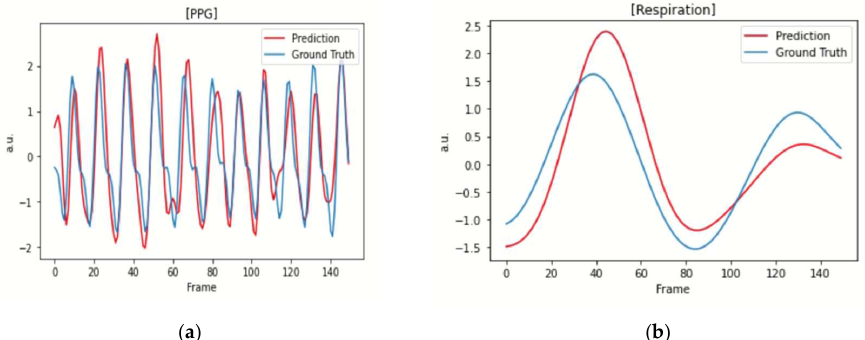
Figure 6. Examples of the predicted PPG and respiratory signals. ( a ) An example of the predicted PPG signal. ( b ) An example of the predicted respiratory signal. Predicted PPG and respiratory signals are plotted in red lines and their true labels in blue lines. Note the high similarity of the MTS model’s predictions to the true labels.